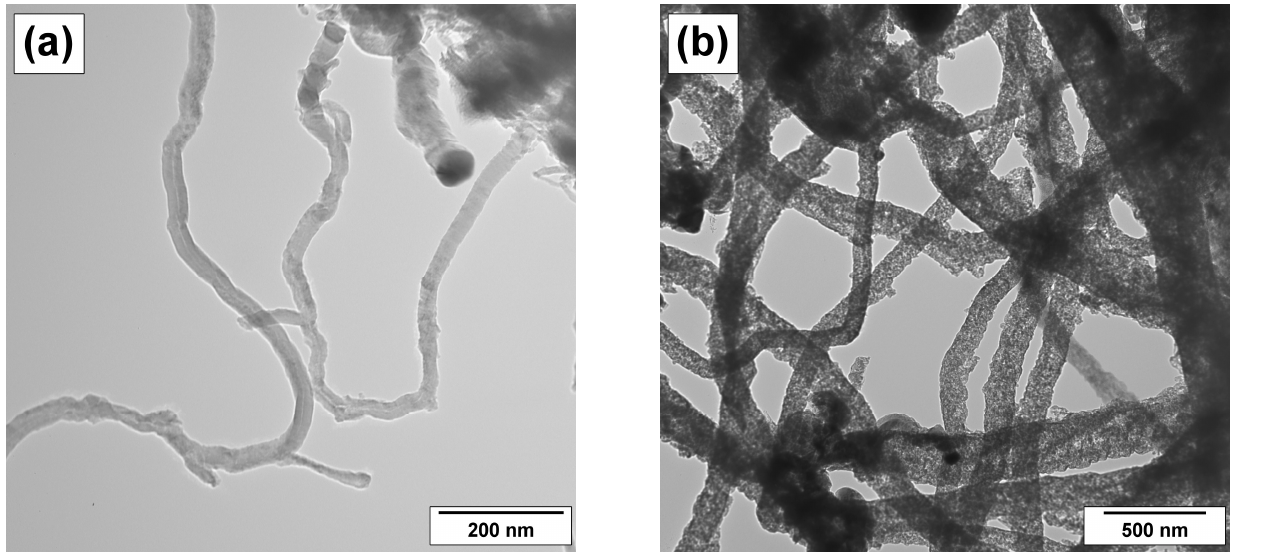
Figure 5. Effect of carbon precursor on the structure of CNFs: ( a ) CNF/CMF; ( b ) CNF/CMF(DCE).